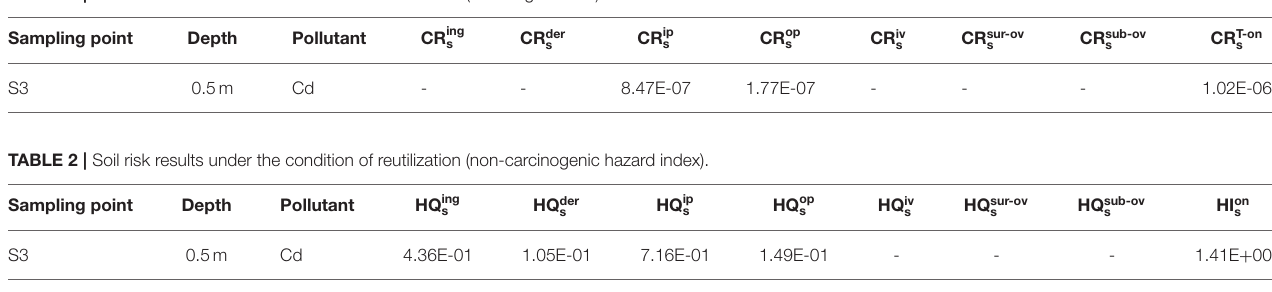
TABLE 3 | Soil risk results under the condition of non-utilization (carcinogenic risk). Sampling point